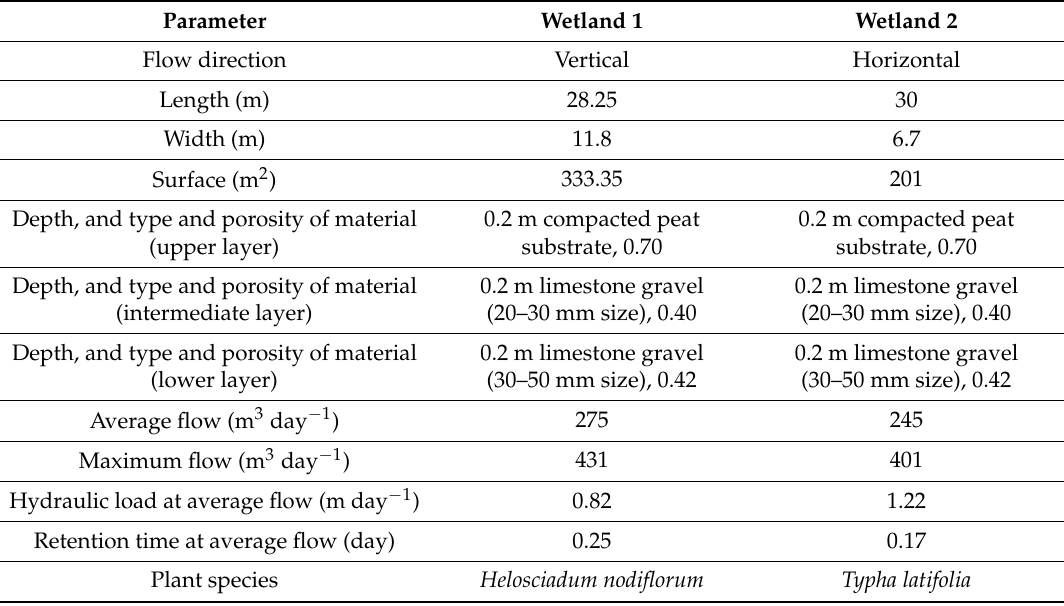
Table 1. Main constructing and operational features of the studied